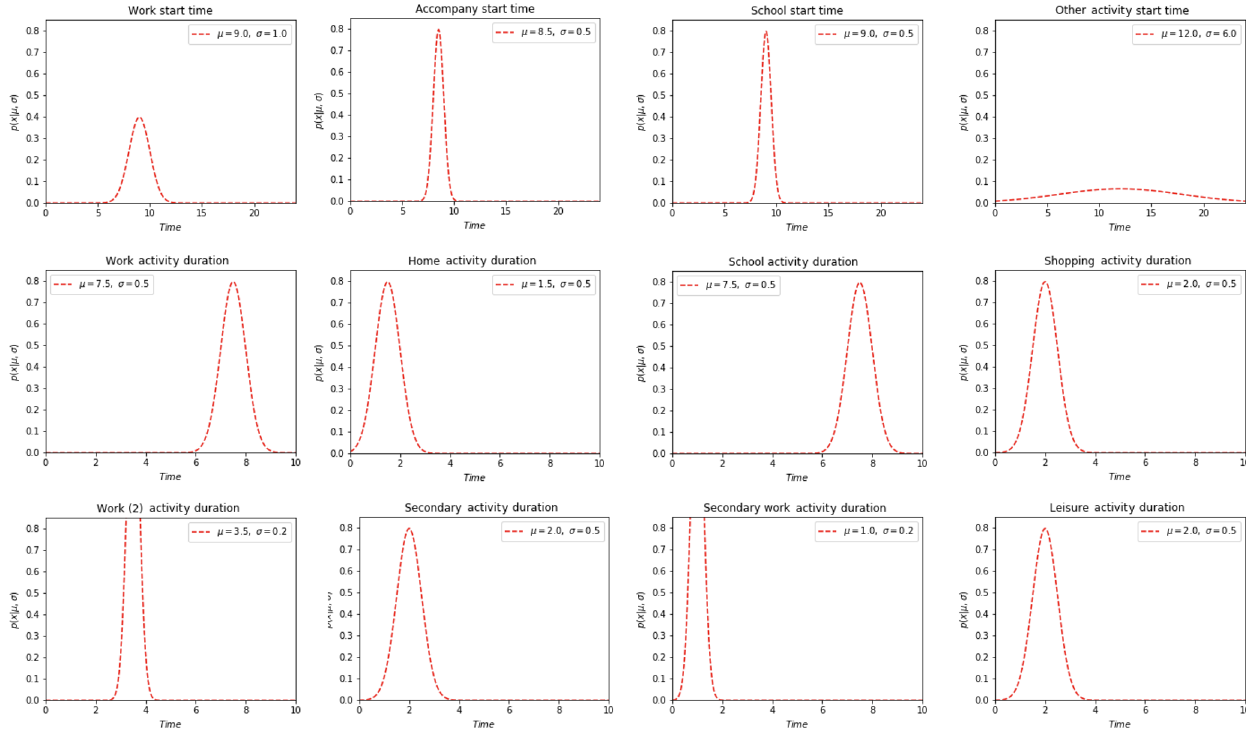
Figure 6. Distribution of activity start times and individual time spent on an